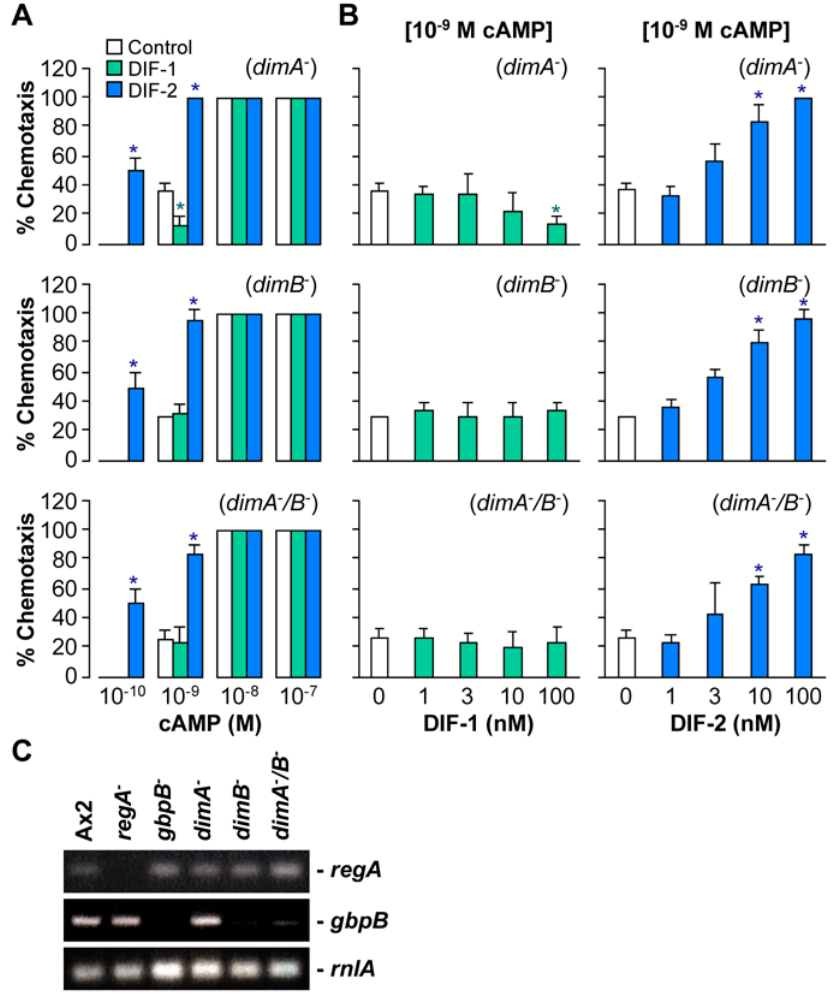
Figure 4. Effects of DIF-1 and DIF-2 on chemotaxis in Dim mutants. (A) Starved (for 6 h) dimA - , dimB - , and dimA - /B - cells were spotted on PB agar containing 3 mM caffeine (Control) plus 100 nM DIF-1 or DIF-2 and assayed for chemotaxis toward the indicated doses of cAMP. Data are the mean and s.d. (bars) of three independent experiments (n=3). (B) Starved dimA - , dimB - , and dimA - /B - cells were spotted on PB agar containing 3 mM caffeine plus the indicated concentrations of DIF-1 or DIF-2 and assayed for chemotaxis toward the doses of cAMP indicated above in square brackets. Data are the mean and s.d. (bars) of three independent experiments (n=3). * P , 0.05, as compared with Control. (C) Expression levels of regA and gbpB . Cells were starved for 6 h, and RNAs collected from the cells were used for semi-quantitative RT-PCR to detect regA, gbpB , and rnlA (internal control).